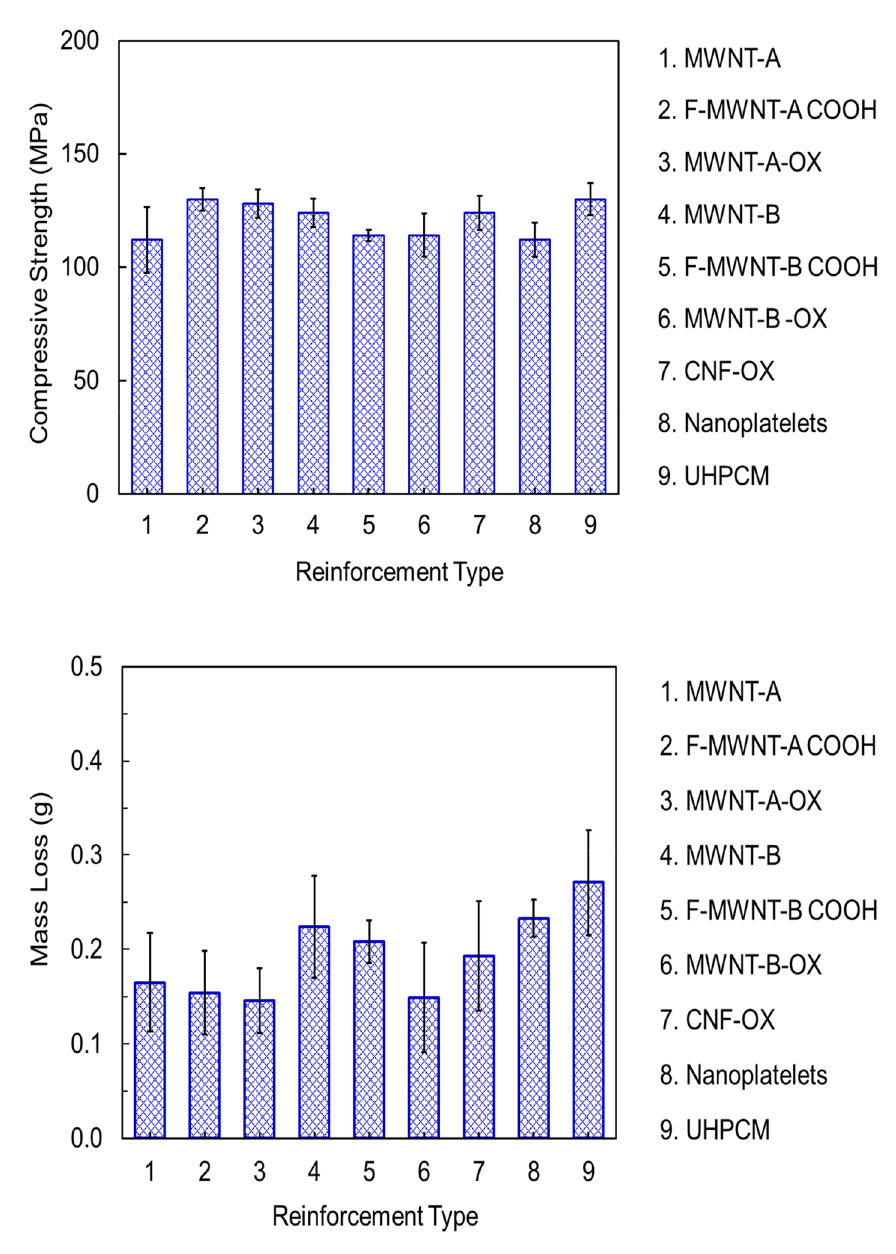
Fig. 7 Compressive strength for UHPCM reinforced with carbon-based nanomateri- als at 0.03 wt.%. Error bars shown are standard deviations determined from 6 replicate samples